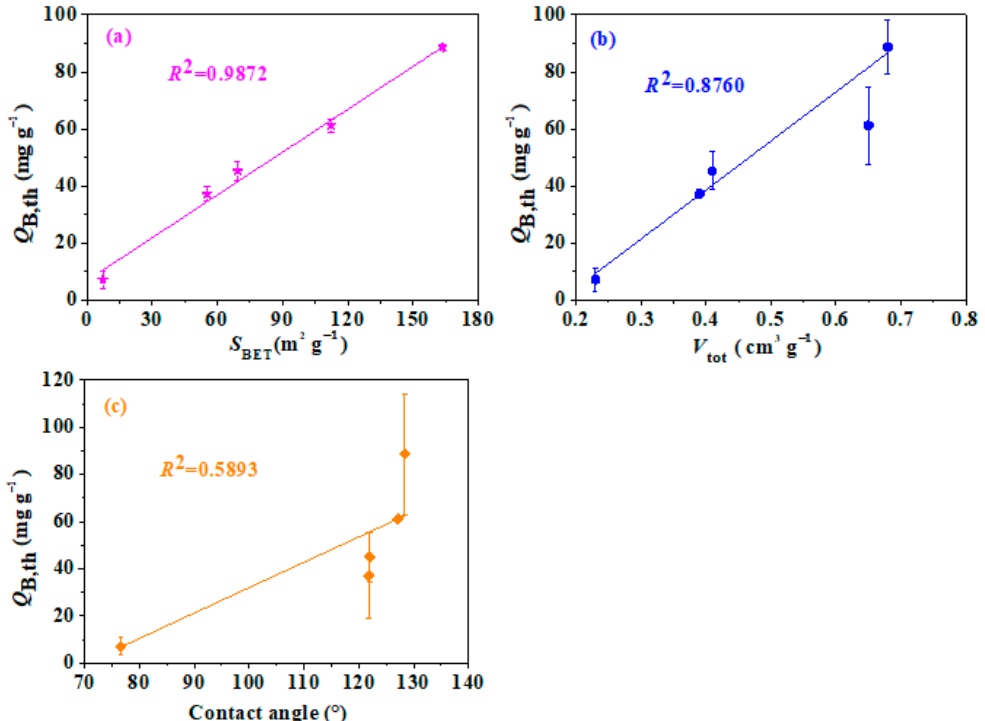
Figure 9. Relationship between Q B and S BET ( a ), Q B and V tot ( b ), Q B and contact angle ( c ) for β -CD-rGOAs adsorbents.